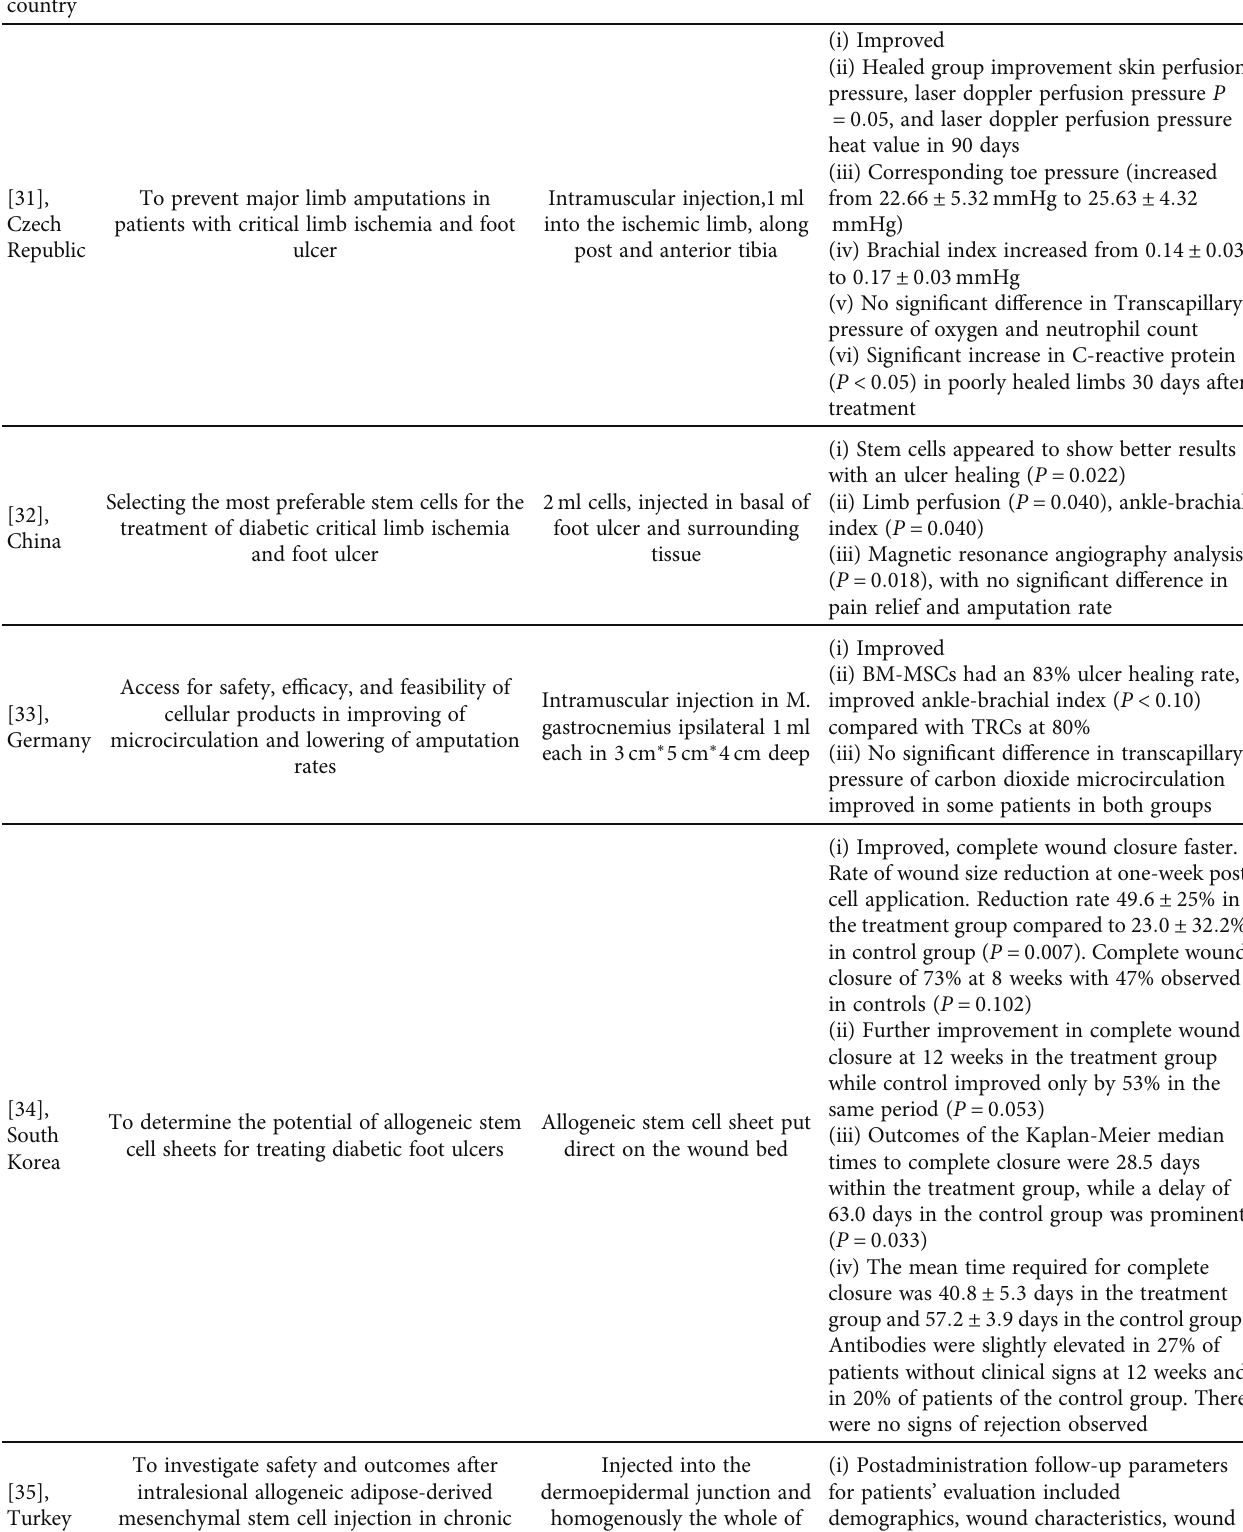
Table 3: Selected studies on stem cell therapy indicating authors, country, aim, mode of administration, and results.